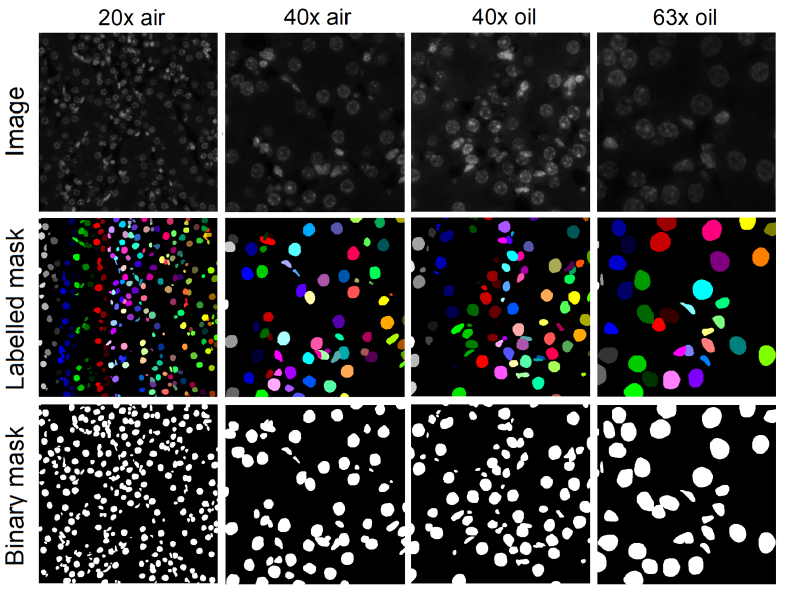
Figure 1. Examples of kidney images at different image magnifications with their corresponding labelled and binary segmentation masks. Table 1. Details of the BitDepth